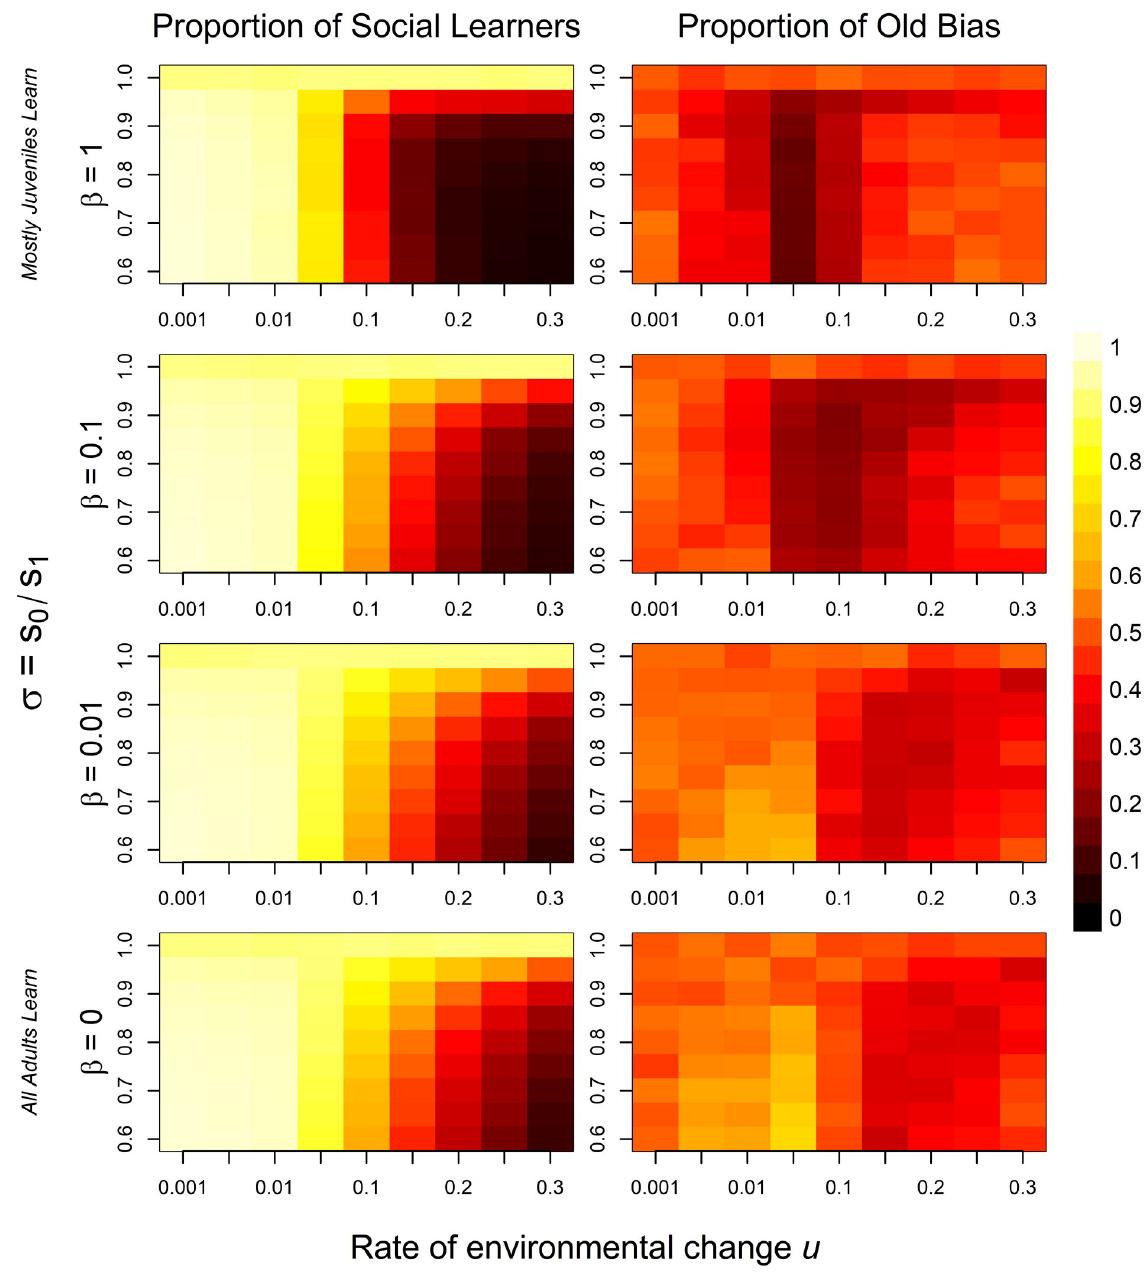
Fig 6. Proportion of social learners (left) and old bias (right) for temporal individual-based model with adult learning. Rows show results for different age-related exponential decline rates in learning; β = 1 means mostly juveniles learn, β = 0 means all age classes are equally able to learn. Squares represent different parameter combinations for the rate of environmental change u and the strength of viability selection σ . Lighter colors indicate higher proportions, darker colors lower proportions. Results are averaged over the last 5000 time steps of 10 independent 7000 time-step simulations per parameter combination. Other parameter values are: c = 0.05, z = 0.5, s 1 = 0.9, μ = 0.005.